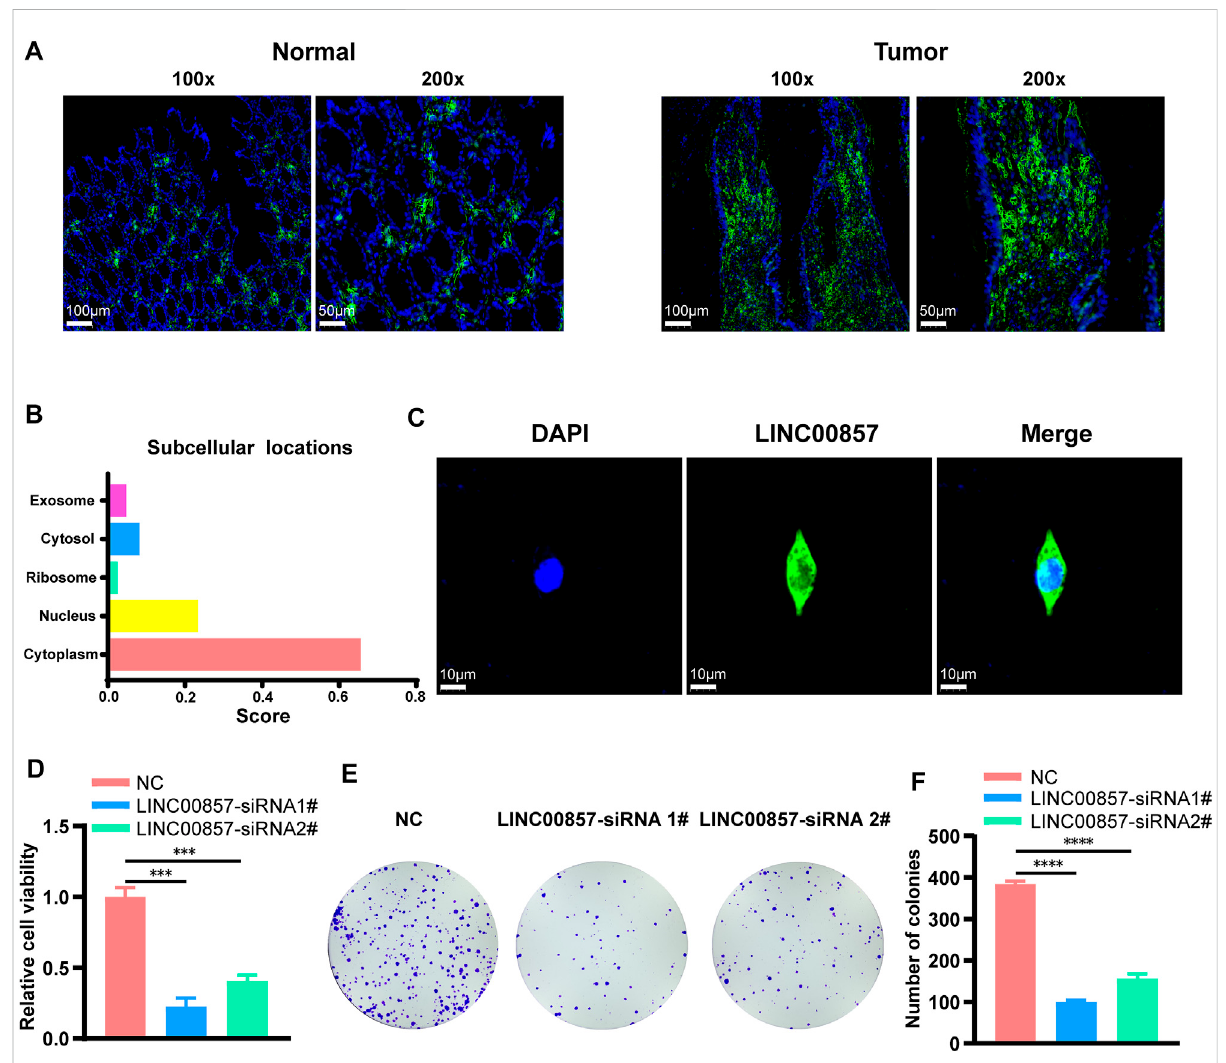
LINC00857 promoted the proliferation of colorectal cancer cells. (A) LINC00857 expression in colorectal cancer and corresponding normal tissues was examined by FISH assay. (B) The subcellular localization of LINC00857 was predicted by lncLocator tool. (C) The subcellular localization ofLINC00857inHCT116cellwasexaminedbyFISH assay. (D) ThecellviabilityofHCT116cellstransfectedwithsiRNA-LINC00857orsiRNA-NCwas evaluated by CCK-8 assay. (E – F) Colony formation experiments monitored the proliferative ability of HCT116 cells after LINC00857